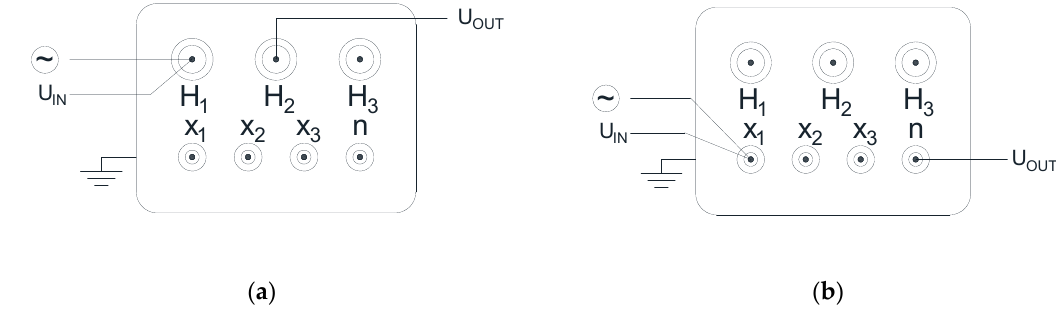
Figure 1. End-to-end open test setup configuration on the example of a Dyn transformer: ( a ) delta winding, ( b ) star winding.